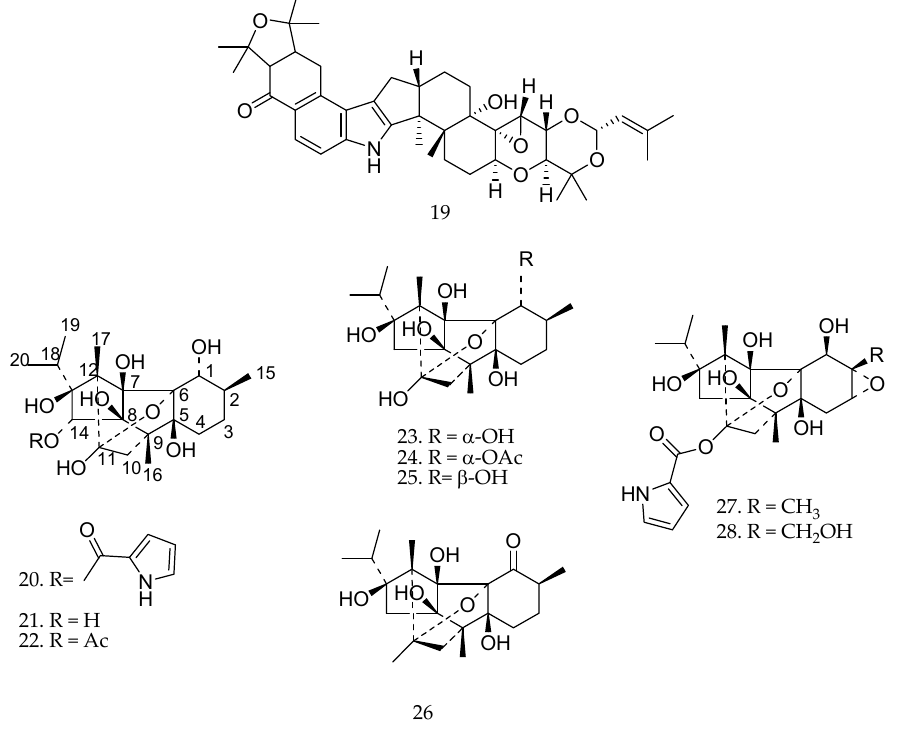
Figure 20. Chemical structures of diterpenes 19 – 28 [100,101].